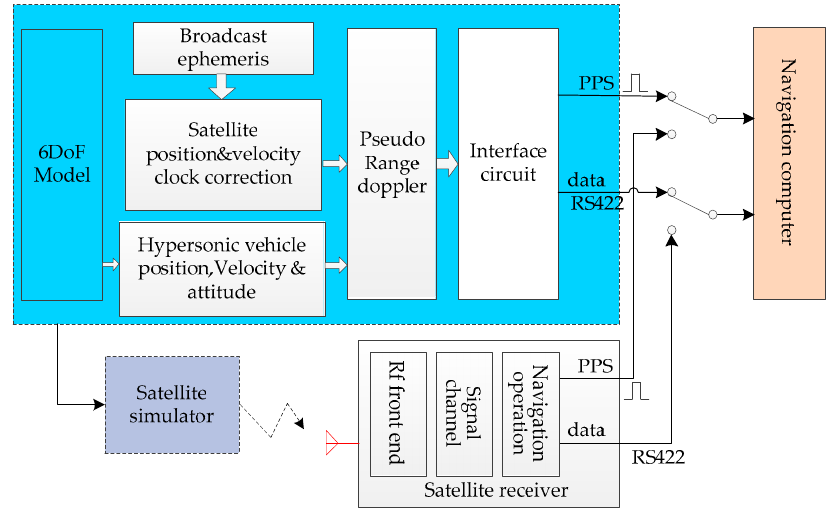
Figure 5. Satellite receiver model.